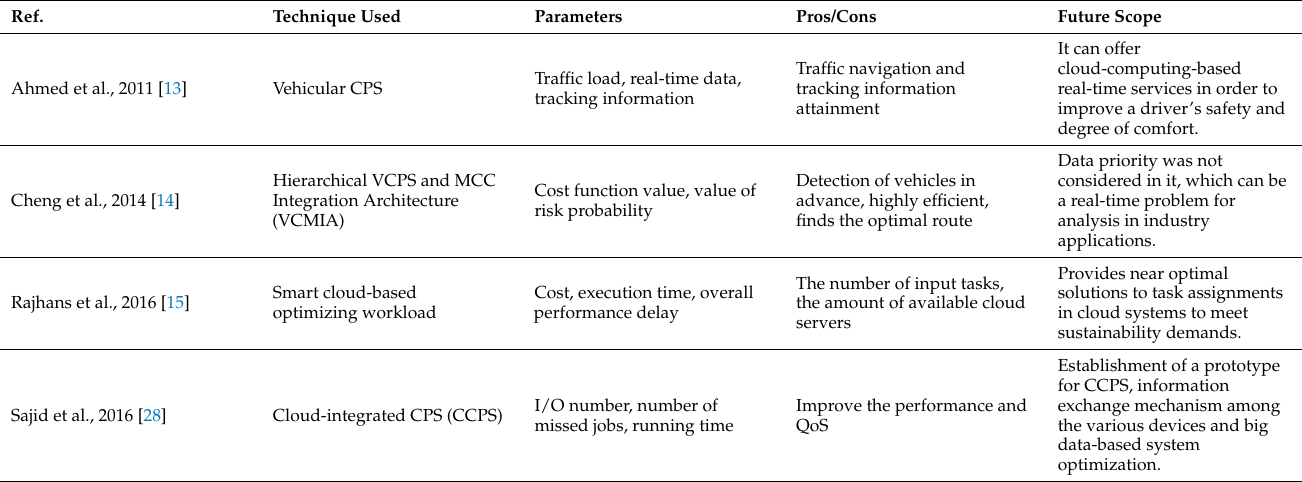
Table 1. Comparitive Analysis of existing